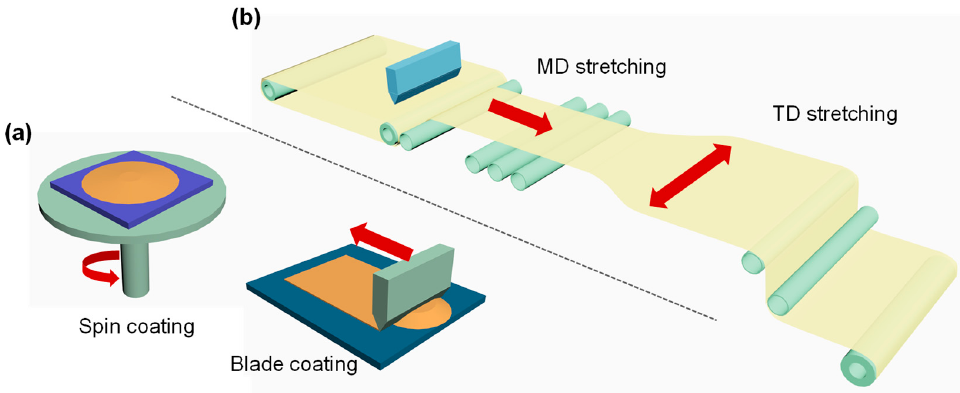
Figure 6. ( a ) Slice ‐ to ‐ slice scale (spin/blade coating) and ( b ) roll ‐ to ‐ roll scale (stretching process) manufacturing for PI films via PAA precursors/PI resin solution. manufacturing for PI films via PAA precursors/PI resin